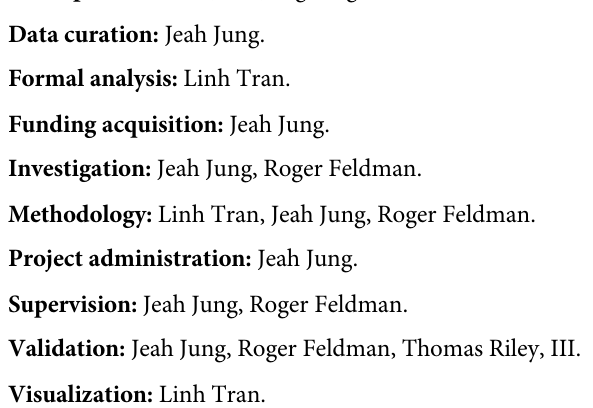
S1 Table. 2016 Physician quality reporting system measures. S2 Table. Proportion of Medicare beneficiaries with hepatitis C and cirrhosis underwent semi-annual hepatocellular carcinoma surveillance. S3 Table. Adjusted odds ratios of undergoing semi-annual hepatocellular carcinoma screening with diagnostic imaging among Medicare beneficiaries with hepatitis C and cir- rhosis (N =